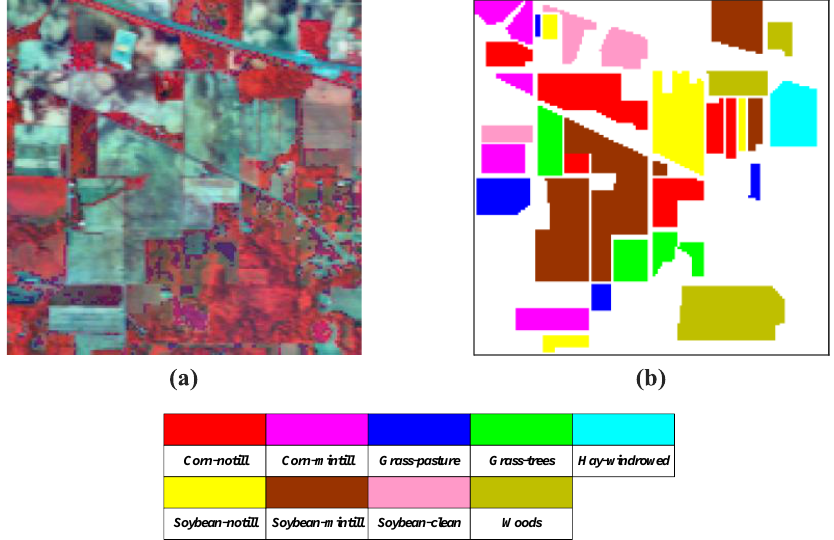
Figure 5. The Indian Pines scene: ( a ) false‑color image and ( b ) ground truth map.